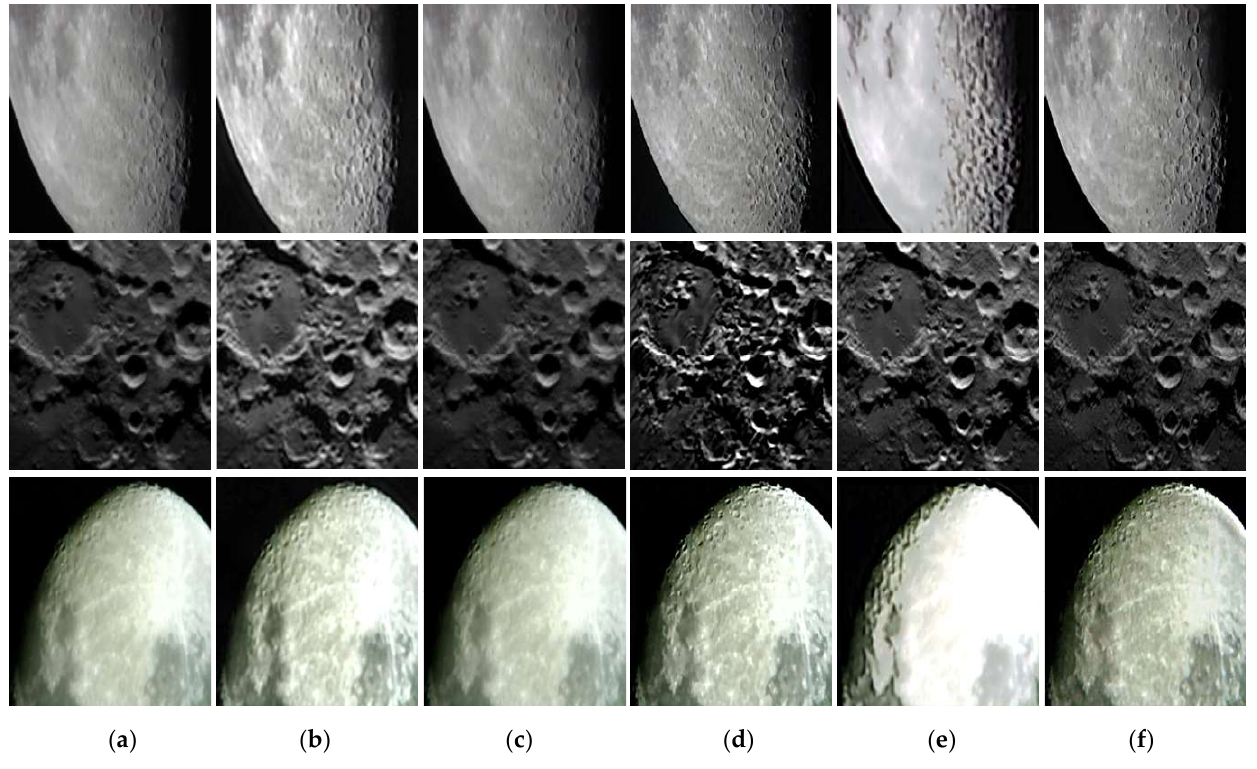
Figure 9. Restored results of turbulence-degraded astronomical object. ( a ) Degraded image; ( b ) CLEAR; ( c ) SGL; ( d ) IBD; ( e ) Gao et al.; ( f ) DTL (Ours).